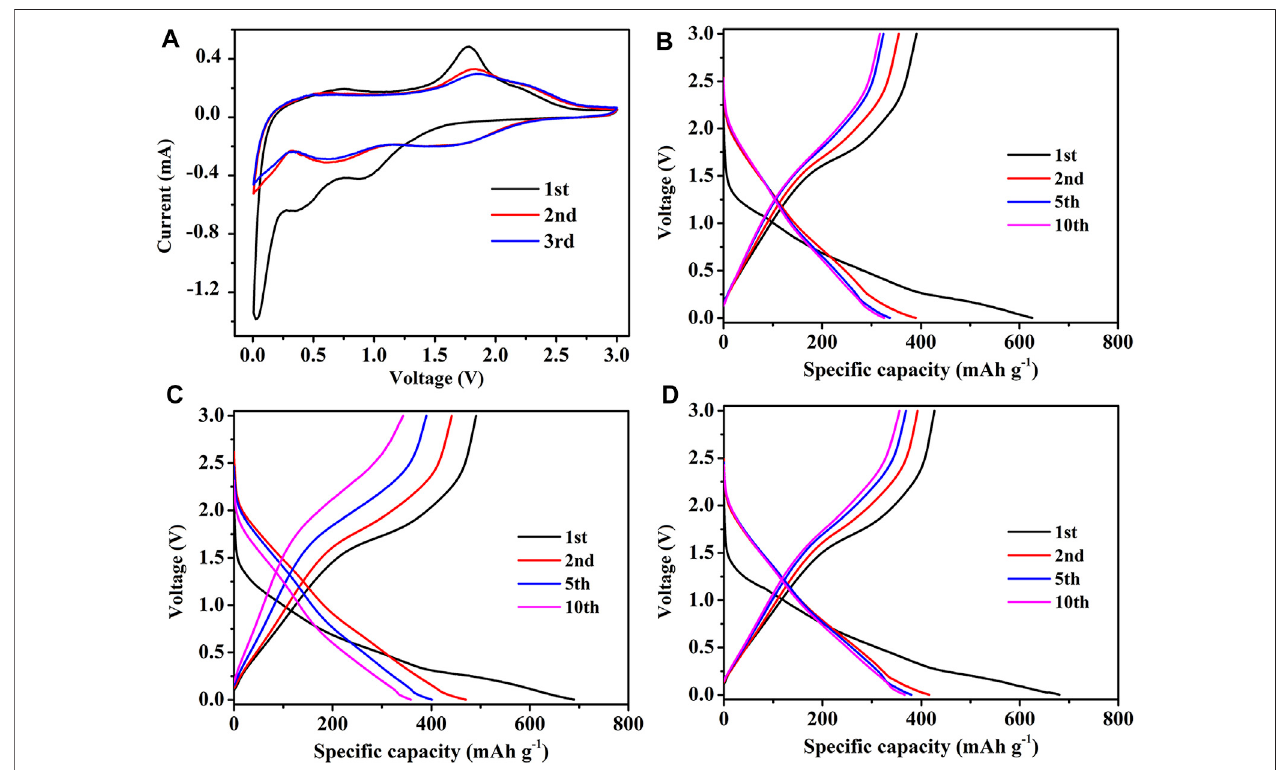
FIGURE 8 | Electrochemical performance of F-MoS 2 @NC as anode of SIBs: (A) CV curves of F-MoS 2 @NC-0.8 electrode at a scan rate of 0.2 mV s − 1 . Charge/ discharge pro fi les of (B) F-MoS 2 @NC-0.8 electrode, (C) F-MoS 2 @NC-0.4 electrode and (D) F-MoS 2 @NC-1.2 electrode at 50 mA g − 1 .